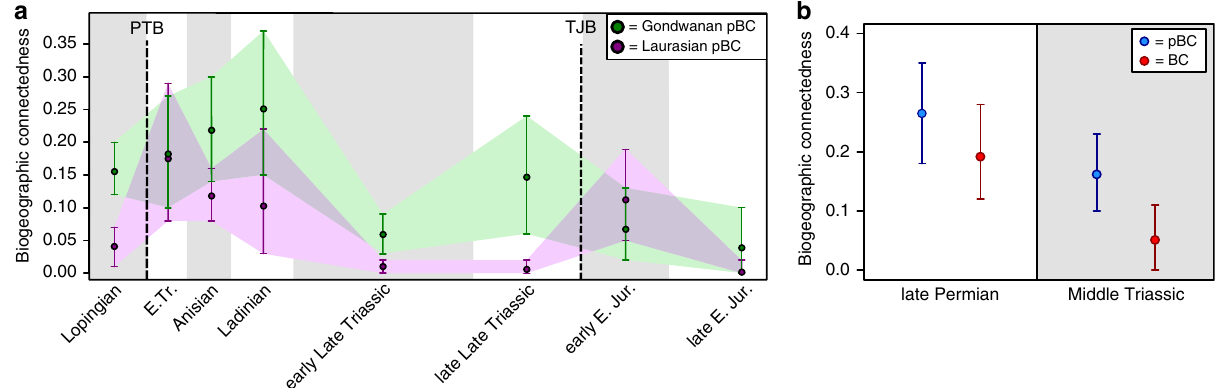
Fig. 5 Results from BC analysis of geographically localized areas. a Comparison of pBC trends during the Lopingian-Early Jurassic from Gondwanan localities (in green ) against those for Laurasia (in purple ). Ninety- fi ve percent con fi dence intervals, calculated from jackkni fi ng with 10,000 replicates, are indicated. b Results from analysis of basin-level terrestrial amniote occurrences from the late Permian and Middle Triassic of southern Pangaea, from the data set of Sidor et al. 3 . Phylogenetic BC results are given in blue , non-phylogenetic BC in red . Ninety- fi ve percent con fi dence intervals, calculated from jackkni fi ng with 1000 replicates, are indicated. Abbreviations as in Fig. 3; E. Jur.: